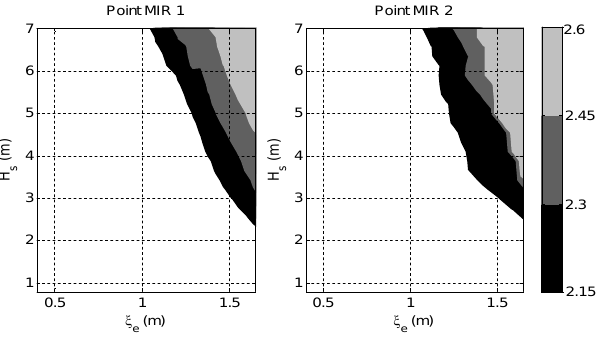
Fig. 7. Best fit of the GPD model and confidence intervals for the marginal distribution of ξ e . Parameters of the GPD calculated with the method of maximum likelihood. Threshold: